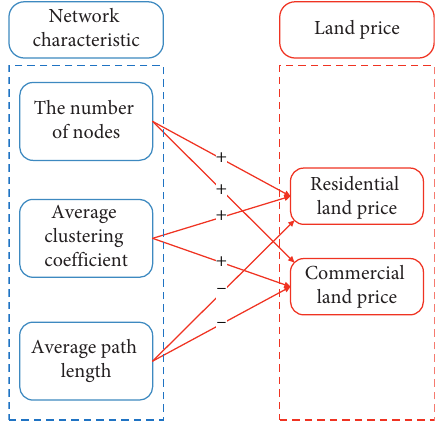
Figure 2: Illustration of research hypotheses to assess the influence of urban rail transit network characteristics on the land